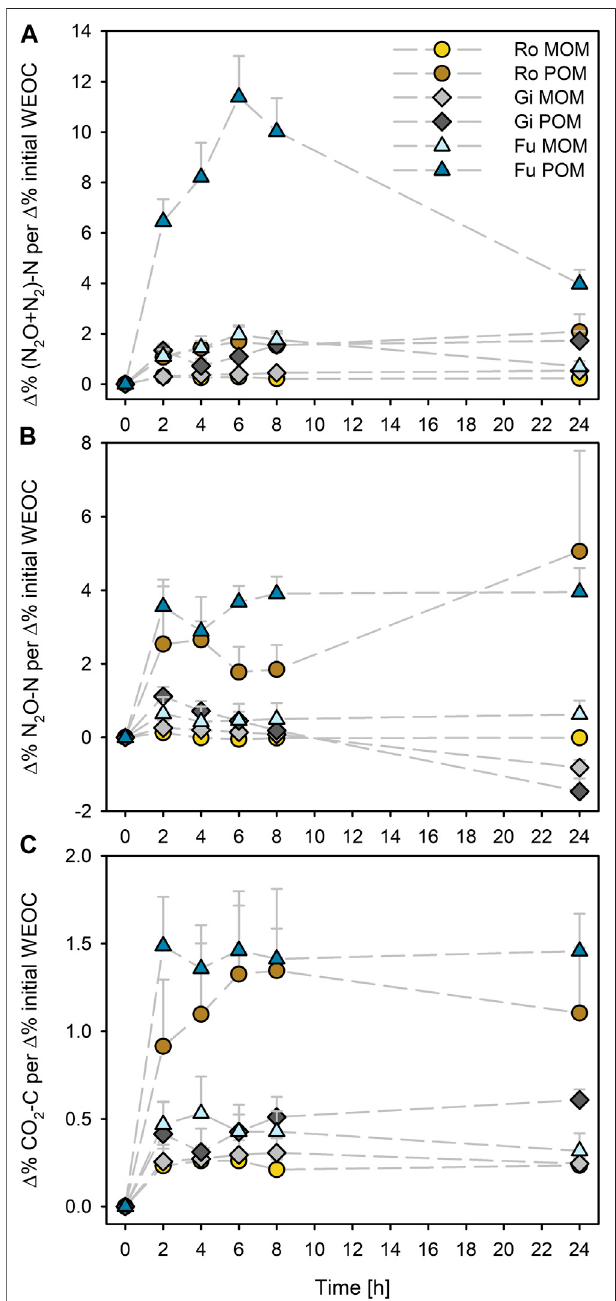
FIGURE2| Percentageeffectofadditionsofsoil-derivedparticulateand mineral-associated organic matter (POM, MOM) on cumulative (A) N 2 O + N 2 , (B) N 2 O, and (C) CO 2 production normalized to percentage of initial WEOC increases compared to the control (without OM addition) during anoxic incubation at 20 ° C of the soils from Rotthalmünster – Ro, Giessen – Gi, and Fuhrberg – Fu. Error bars represent SD of means (n (cid:2)